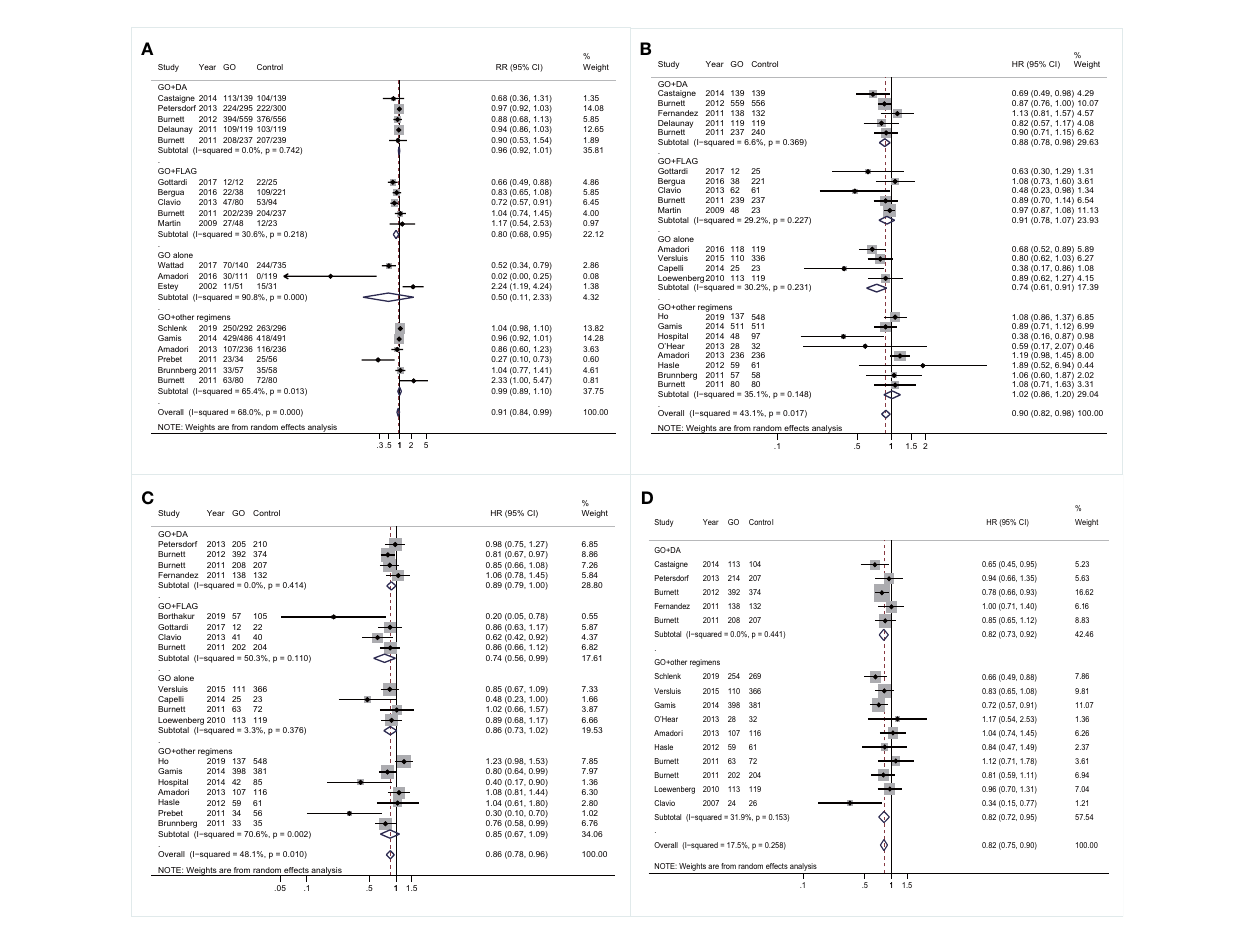
FIGURE 7 | Prognostic subgroup analyses regarding combined regimens of GO. (A) CR. (B) OS. (C) RFS. (D) CIR. The diamonds represent the overall summary RR and HR estimates with 95% CI. GO, gemtuzumab ozogamicin; CR, complete remission; OS, overall survival; RFS, relapse-free survival; CIR, cumulative incidence of relapse; RR, relative risk; HR, hazard ratio; 95% CI, 95% con fi dence interval; DA, daunorubicin plus cytarabine; Ara-C, cytarabine; FLAG, fl udarabine, Ara-C, and granulocyte colony-stimulating